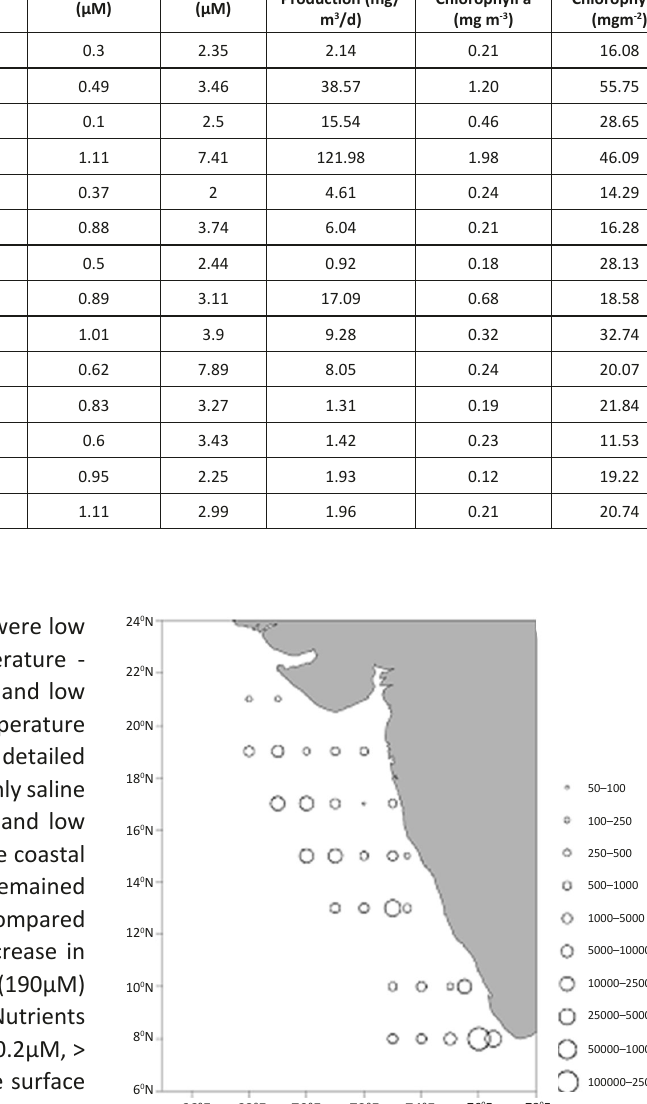
Table 1. Values of environmental and biological parameters such as dissolved oxygen, nutrients and chlorophyll a along the oceanic and coastal stations. Latitude Oceanic/ ( 0 N) Coastal